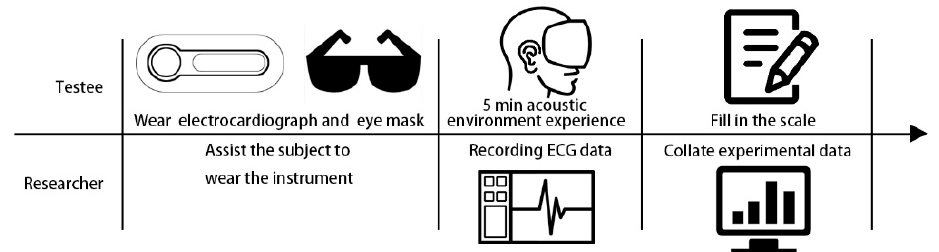
Figure 6. Flow chart of experimental unit.